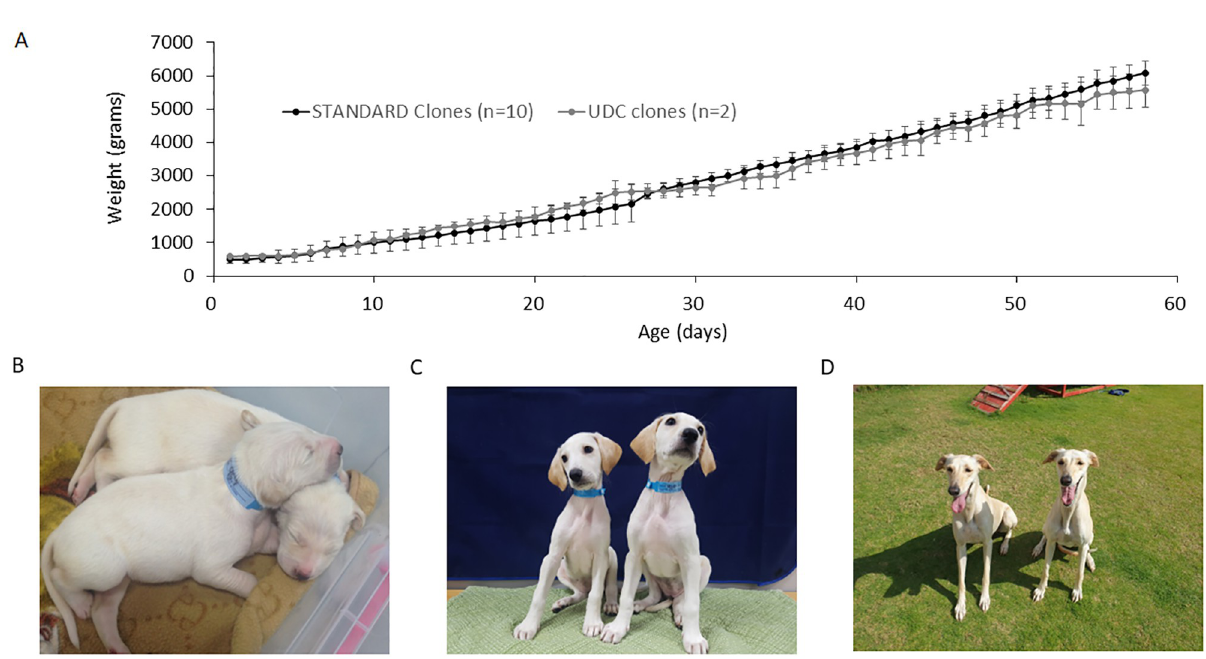
Fig 6. Growth and Development of standard SCNT and UDC clone development A) Growth rate until weaning, B) newborns, C) UDC clones at 4 months of age, D) mature UDC clones. Error bars ae SD.